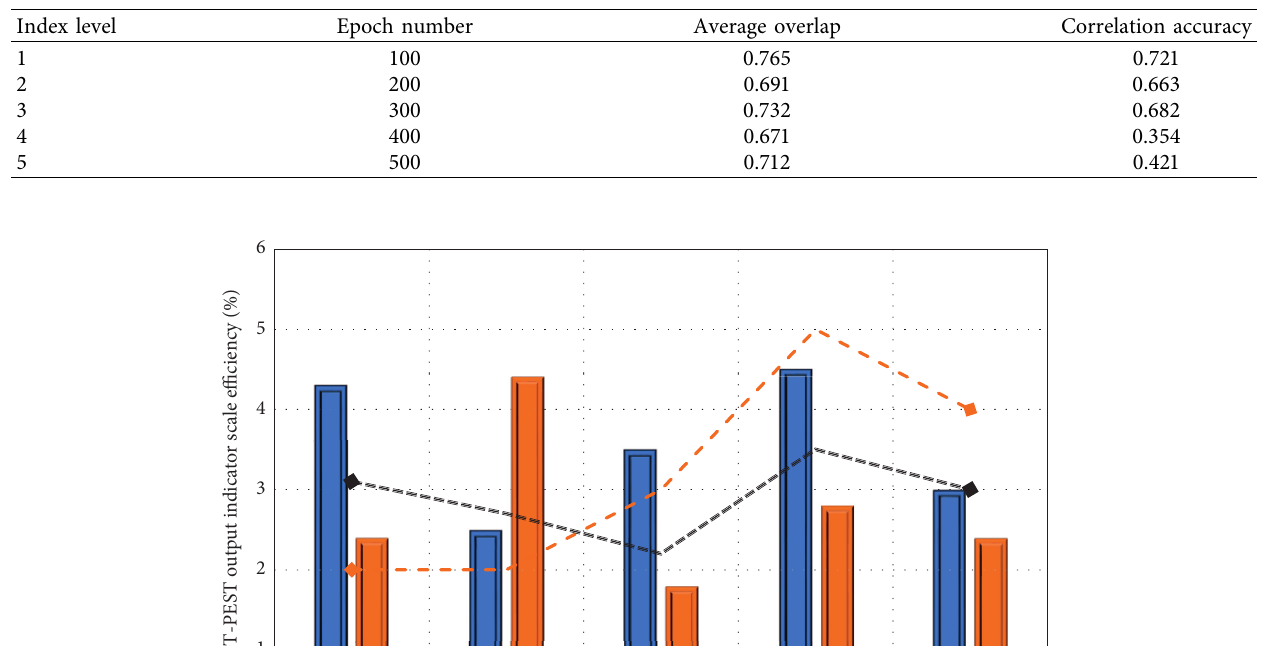
Figure 6: SWOT-PEST efficiency status evaluation. Table 2: SWOT-PEST efficiency correlation analysis.